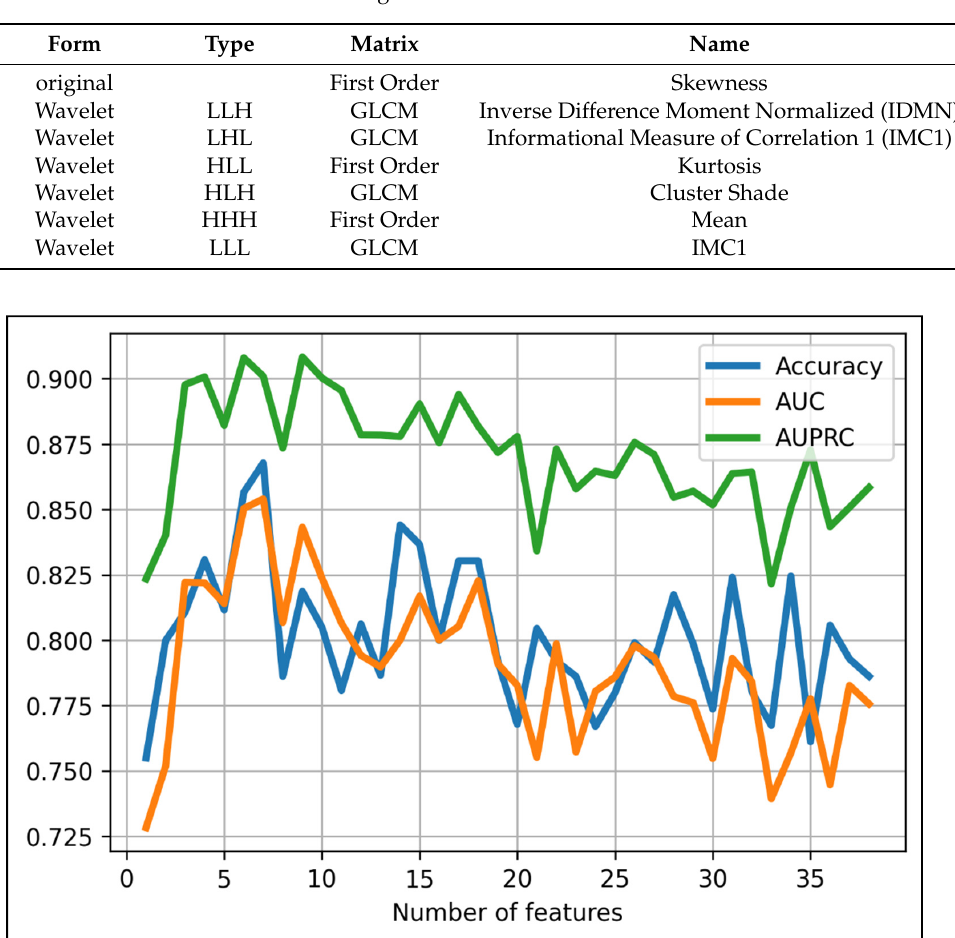
Figure 2. Performance results when using different numbers of top-rank features in predicting 1p/19 status using XGBoost algorithm. The optimal cut-off point belongs to the first seven features (accuracy = 87%).